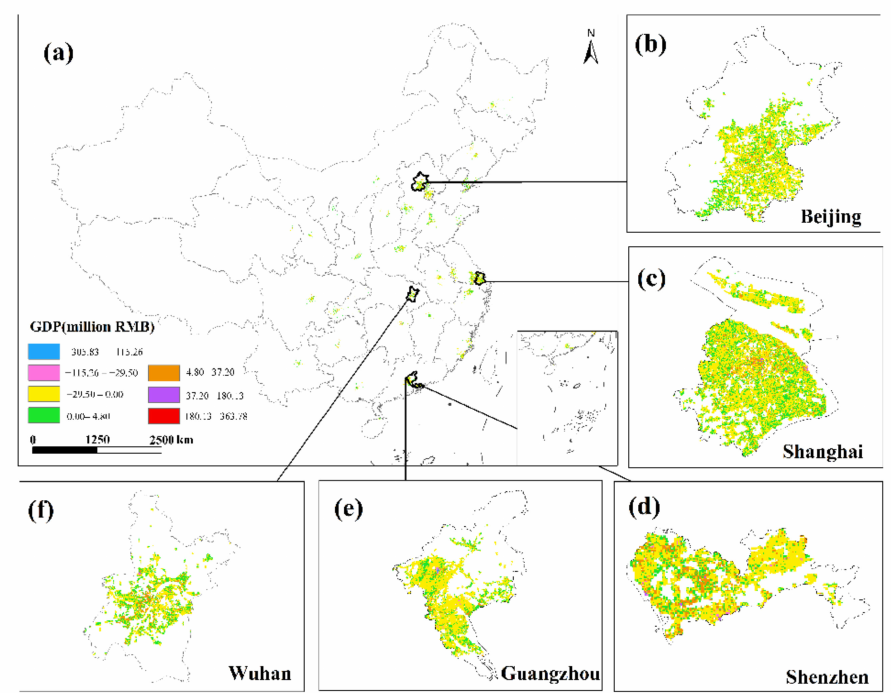
Figure 17. The spatialized result of the sum of GDP in May minus the sum of GDP in April. ( a ) The changes in GDP of 34 cities in China from April to May; ( b ) Beijing; ( c ) Shanghai; ( d ) Shenzhen; ( e ) Guangzhou; ( f ) Wuhan.